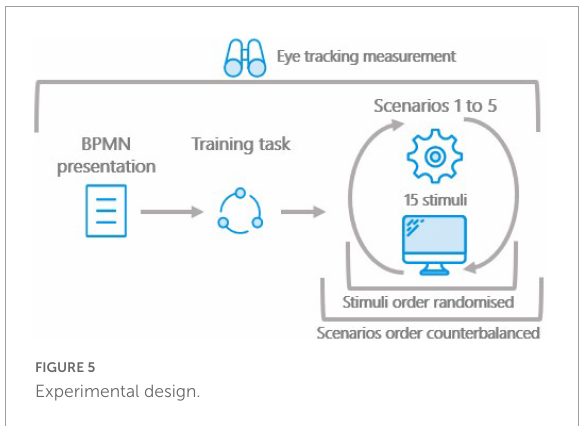
FIGURE5 Experimental